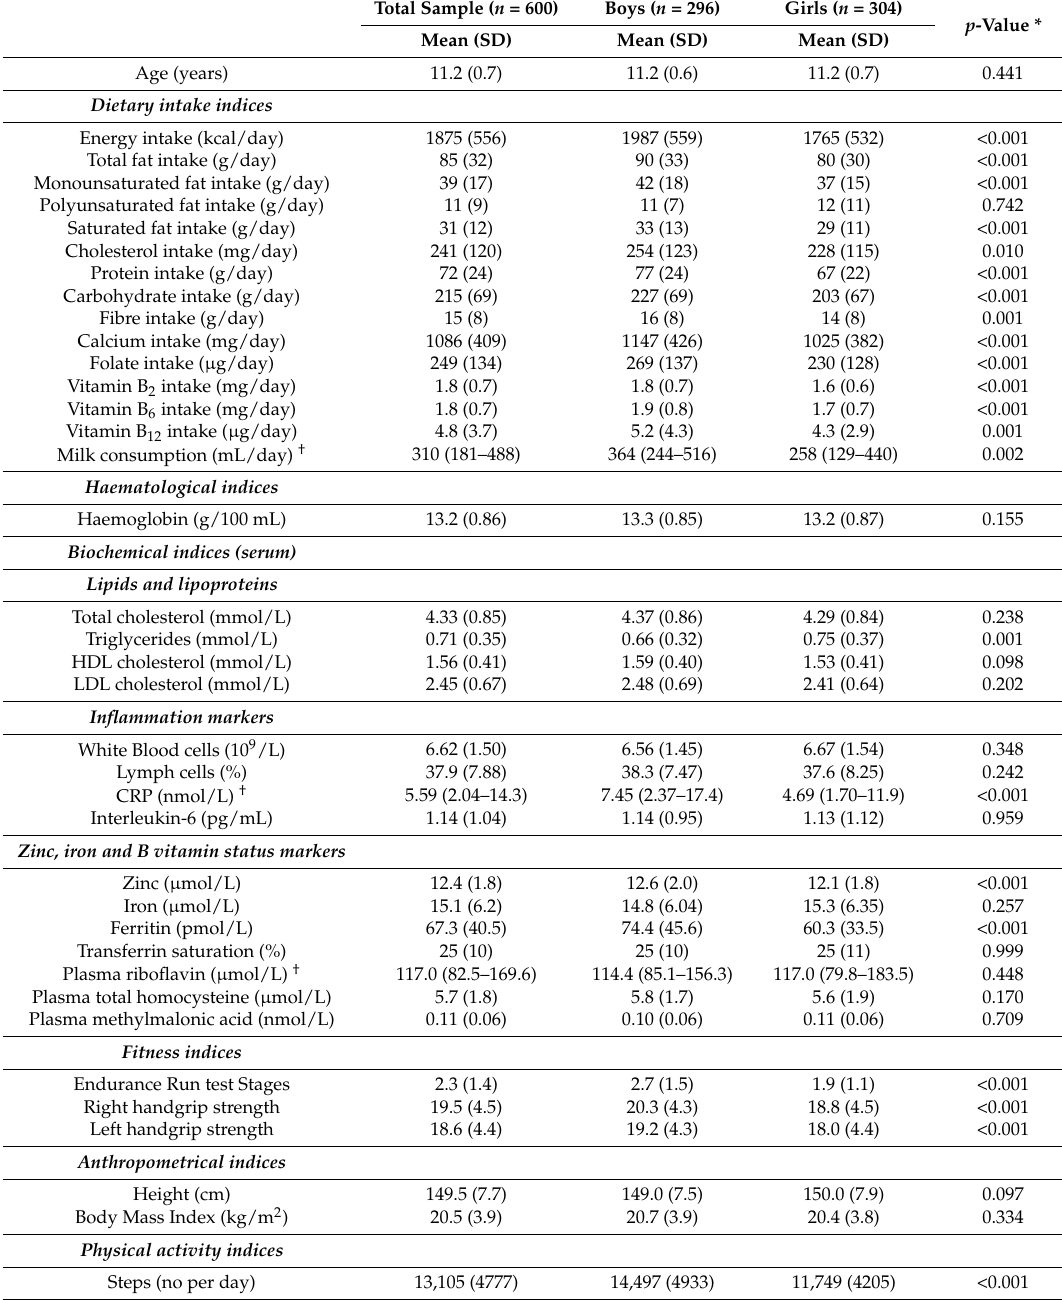
Table 1. Average age and levels of dietary intake, haematological, biochemical, fitness, anthropometrical and physical activity indices in the total sample and by